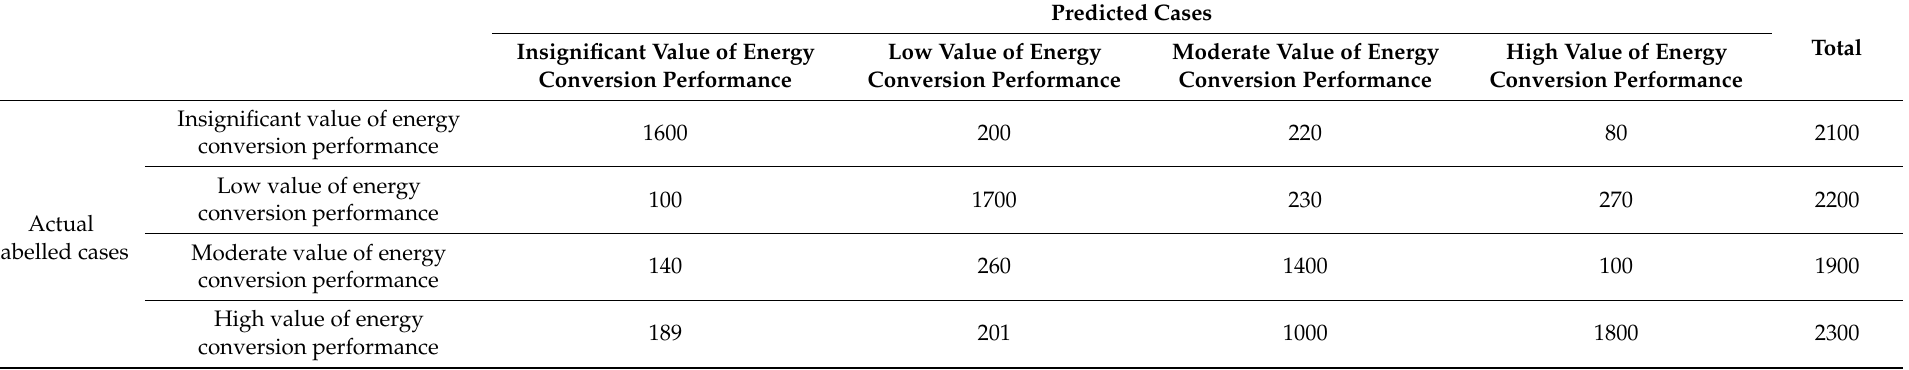
Table 6. Confusion matrices for value of energy conversion performance without the transfer learning.